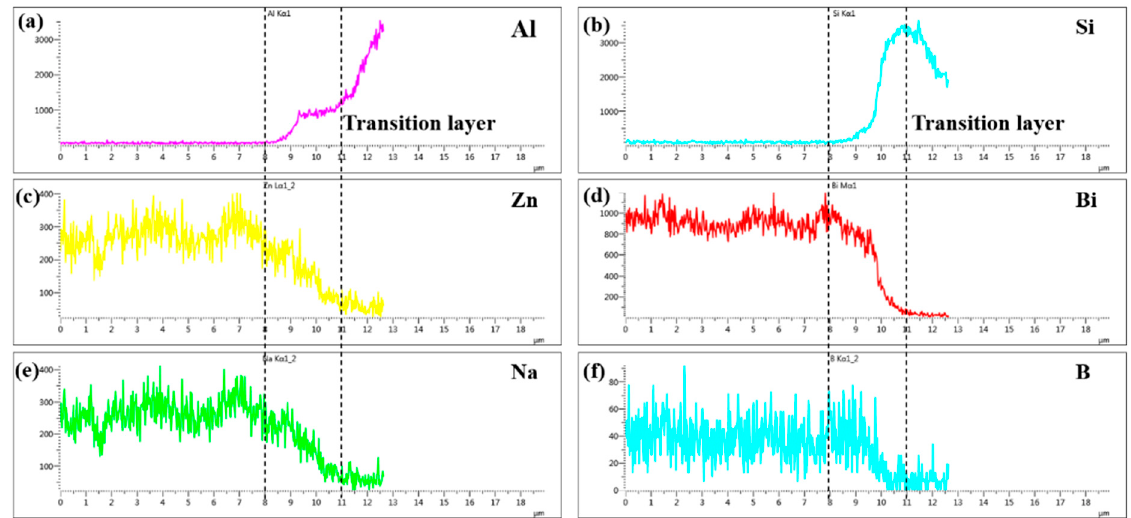
Figure 10. Line scanning profile of different elements at line L1 marked in Figure 9b: ( a ) Al; ( b ) 495 Si; ( c ) Zn; ( d ) Bi; ( e ) Na and ( f ) B.